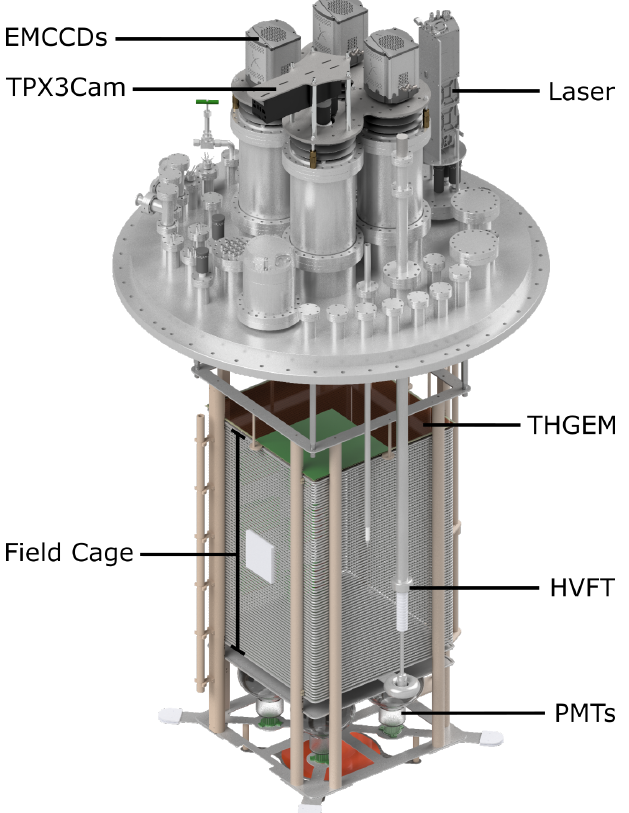
Figure 1. A CAD model of the ARIADNE detector, with major components highlighted. The reflector panels have been omitted for clarity. Alongside the TPX3Cam are 3 EMCCDs, but these are shown only for illustrative purposes—their operation and results have previously been discussed in [18] and are not elaborated in this paper. The green region indicates the 32 cm × 32 cm field of view of the